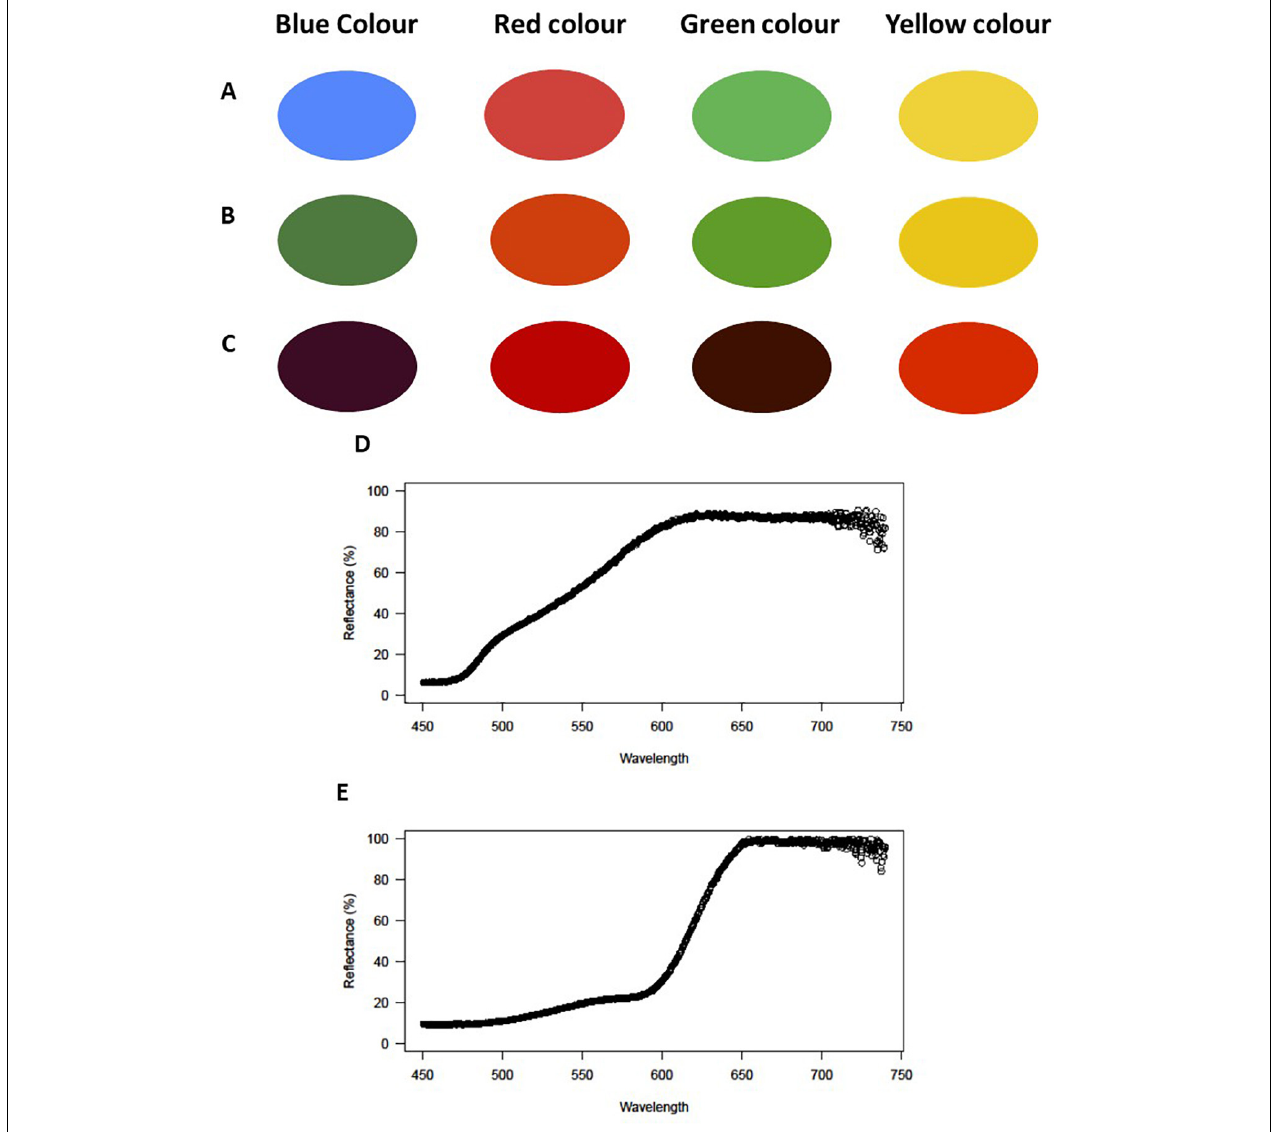
FIGURE 2 | Simulated effect of water color on light transmission across the water column for different wavelengths (blue, red, green, and yellow colors) as observed. (A) without wavelength bias (e.g., in clear water), (B) through an orange light filter ( Figure 2D ) simulating the black water light condition at ∼ 40 cm deep, and (C) under a red light filter ( Figure 2E ) simulating the light condition at ∼ 150 cm of depth in a black water environment. Reflectance by wavelengths with (D) an orange light filter to simulate a black water light condition at ∼ 40 cm deep, and (E) with a red light filter to simulate a black water light condition at ∼ 150 cm